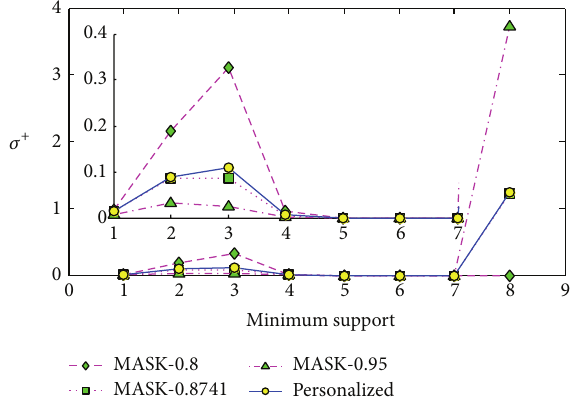
Figure 14: Frequent itemset added ration 𝜎 + versus itemset length 𝑘 on dataset